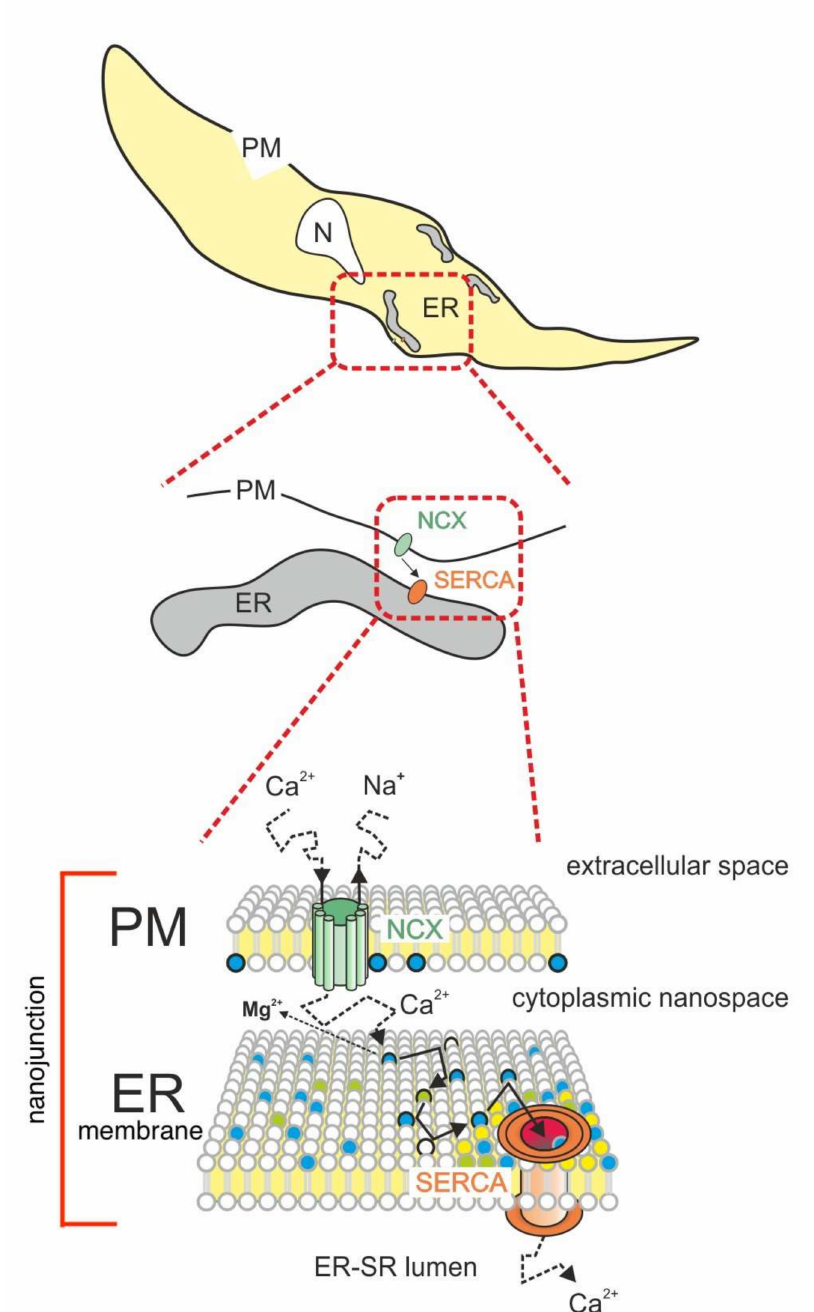
Figure 2. This cartoon illustrates a simplified hypothetical mechanism for refilling the ER at a NJ between the PM and ER. The proposed process of Ca 2+ transfer between extracellular space and ER lumen is depicted in a cutout representing a distinct PM-membrane and ER-membrane-delimited nano-space (lower panel) of a cell (upper panel). Ca 2+ enters the NJ via rNCX, where it performs a 3D random walk, and when it hits the ER surface, it proceeds by 2D exchange diffusion on the negatively charged heterogeneous PL surface of the peripheral ER. During a Ca 2+ pulse, most of the Mg 2+ associated with fixed coordination sites at the NJ membrane surface will be displaced into the aqueous phase. Both annular (yellow circles) and non-annular (non-yellow circles) lipids of the Ca 2+ target protein may further facilitate guidance of Ca 2+ into the transmembrane transport sites of